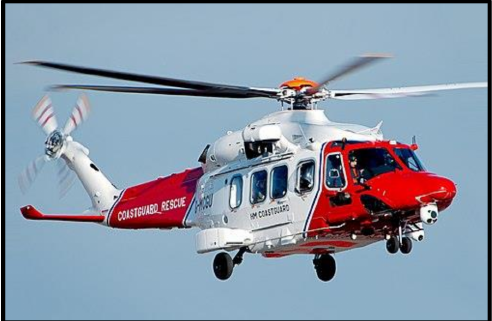
Figure 2. AgustaWestland AW189. Reproduced under a Creative Commons Licence from